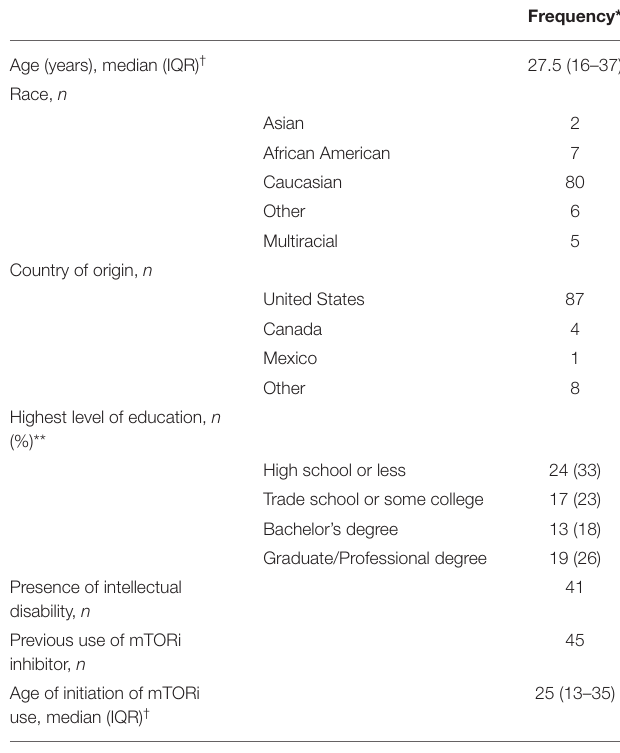
TABLE 1 | Demographics of all respondents, n =